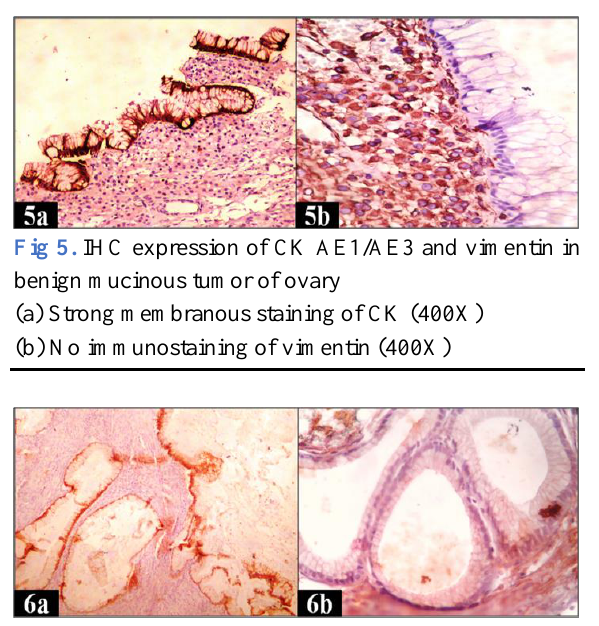
Fig 3. IHC expression of CK AE1/AE3 and vimentin in borderline serous tumor of ovary (a) Strong membranous staining of CK(100X) (b) Mild cytoplasmic expression of vimentin (400X)